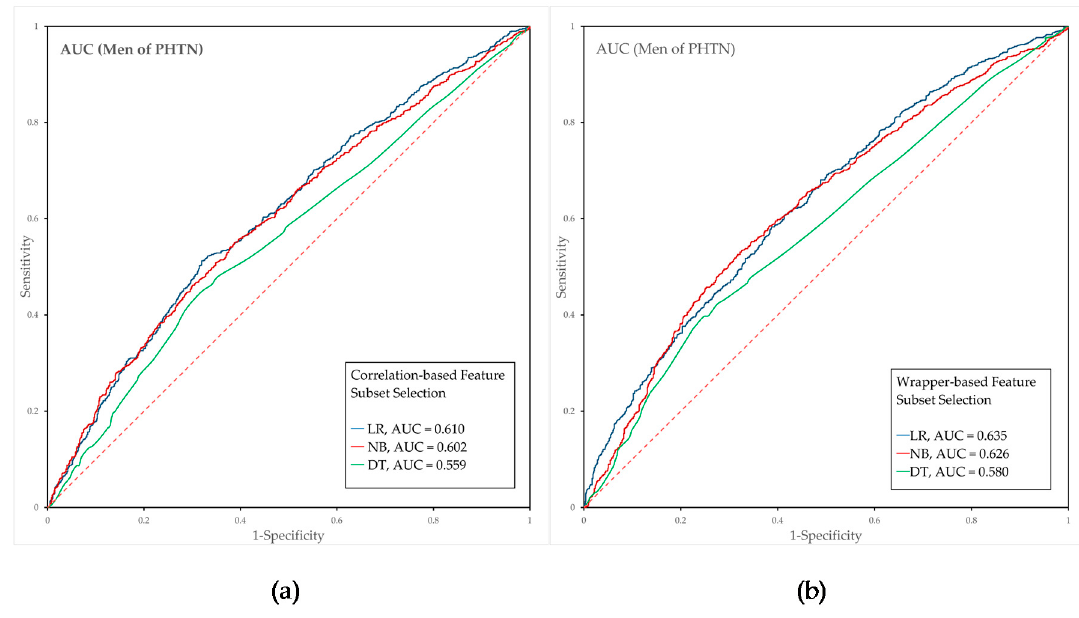
Figure 2. Figure 2. Cont.